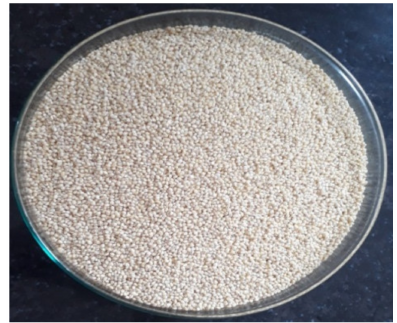
Figure 1. Proso millet grains.